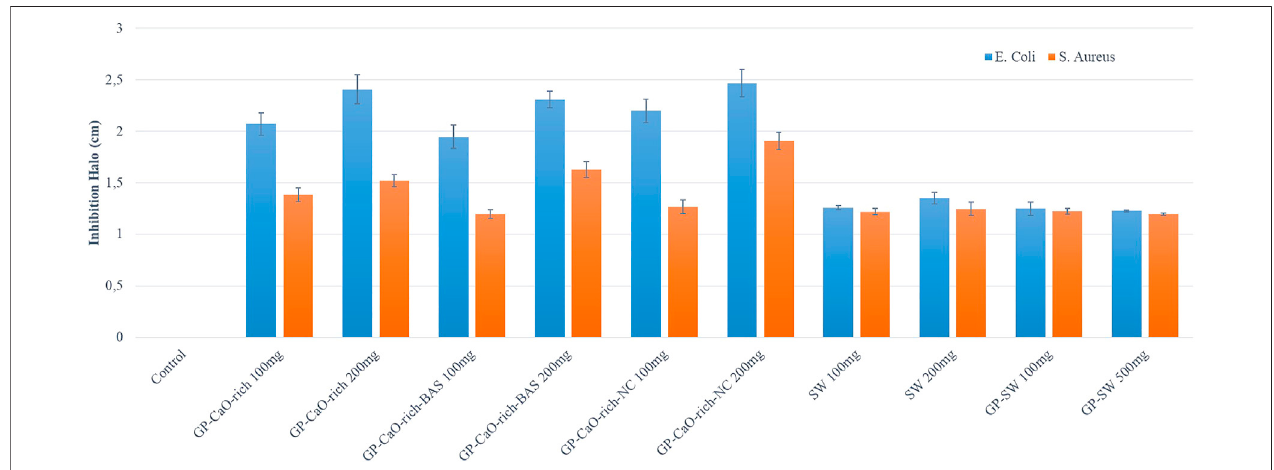
FIGURE 9 | Inhibition halo of E. coli and S. aureus in presence of all the tested samples at growing amounts of powder (100 and 200 mg, in most of the cases).